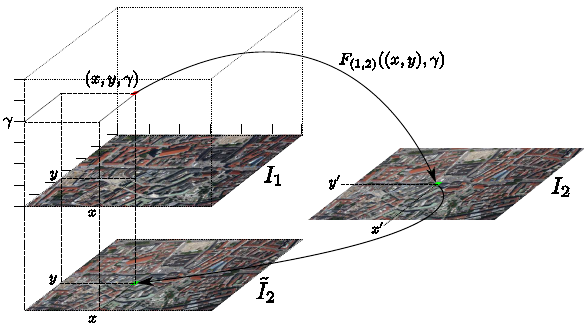
Figure 2: Computation of the disparity space image using a plane-sweep approach: For a coordinate ( x, y ) in image I 1 and disparity γ , obtain the corresponding coordinate ( x 0 , y 0 ) in image I 2 using the camera model F 1 , 2 , sample the pixel color/intensity and copy it to the warped image ˜ I 2 at position ( x, y ) . The match- ing cost can then be computed by comparing the pixel intensities in both images at position ( x, y )